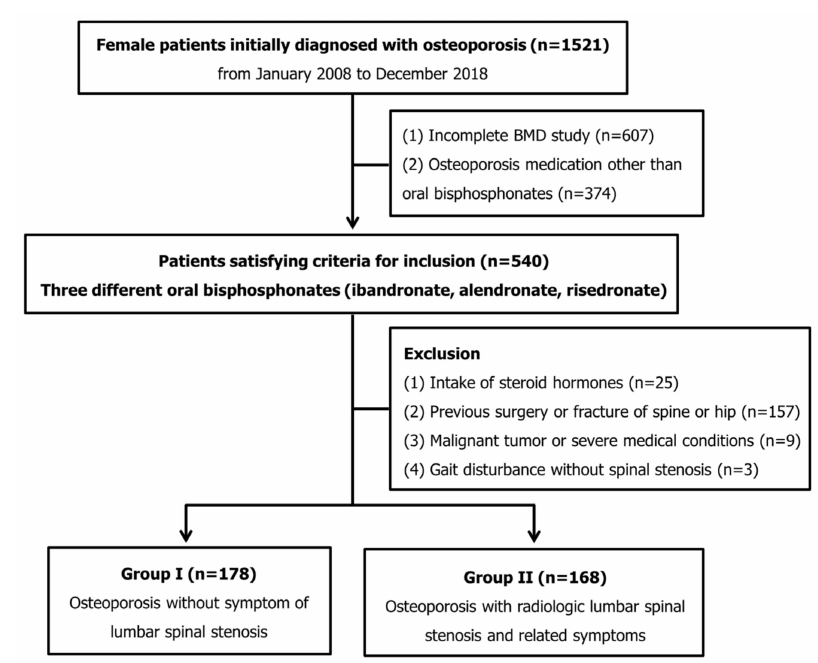
Figure 1. Flow chart of patient inclusion in this